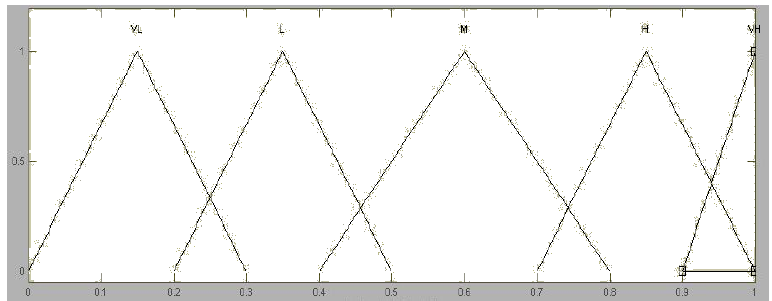
Fig. 2. Membership function of linguistic